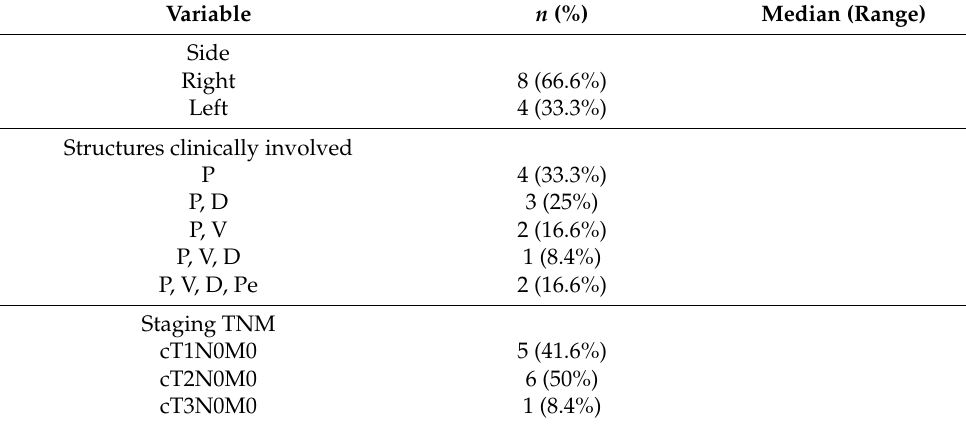
Table 2. Clinical and pathological stage, type of surgery and structures resected, dosage of intraoper- ative cisplatin and post-operative